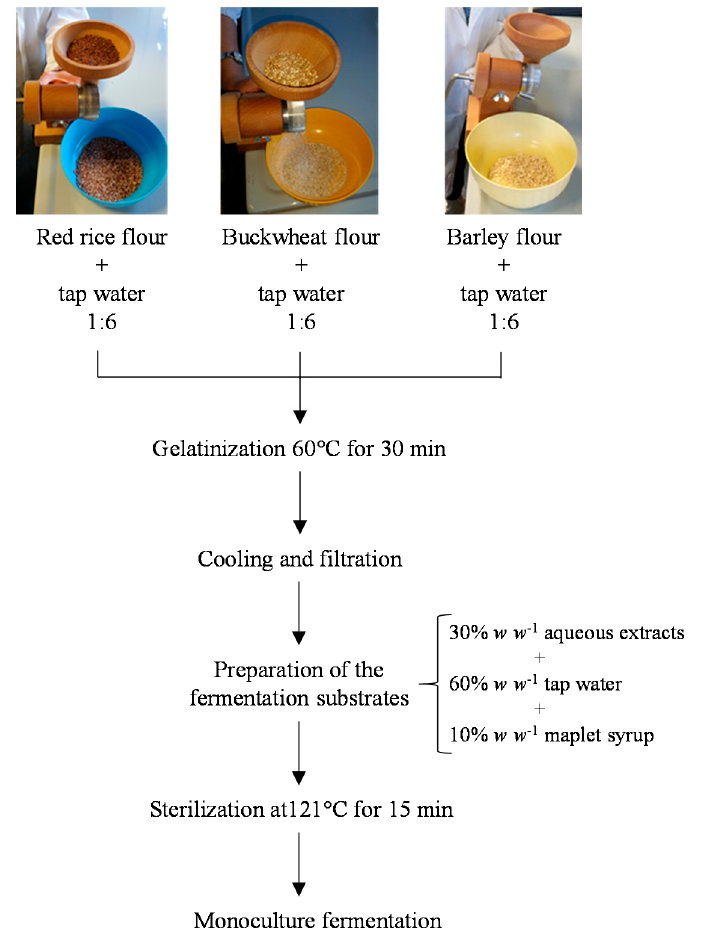
Figure 1. Flow chart of preparation of the ad hoc formulated fermentation substrates .